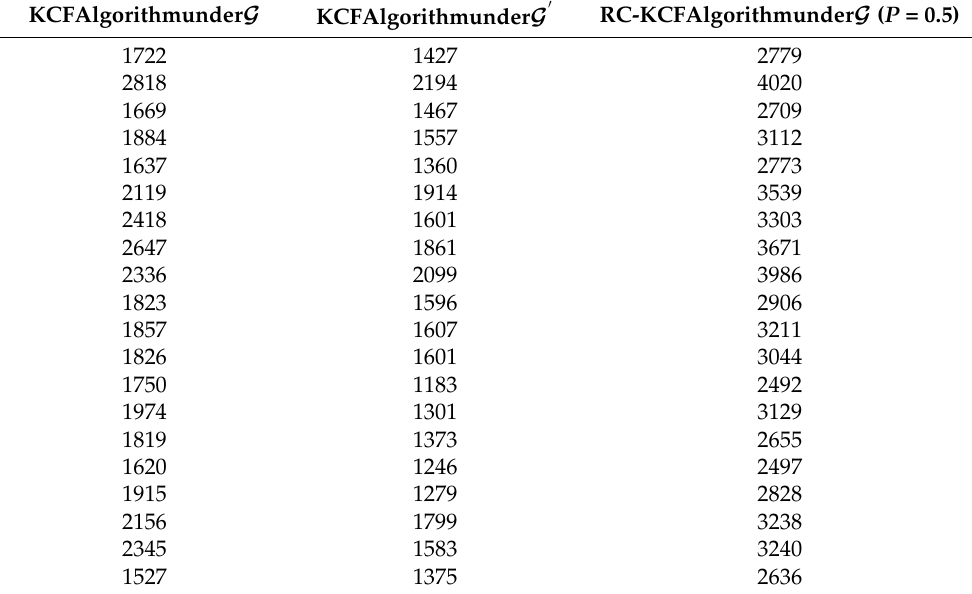
Table 2. Comparison of the number of iterations, and P = 0.5.